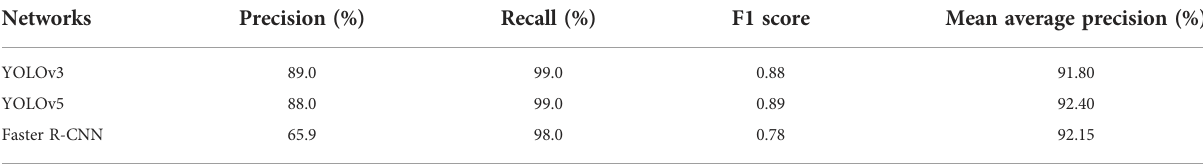
TABLE 4 Weed identi fi cation model training results using YOLO and Faster R-CNN networks with Weed25.